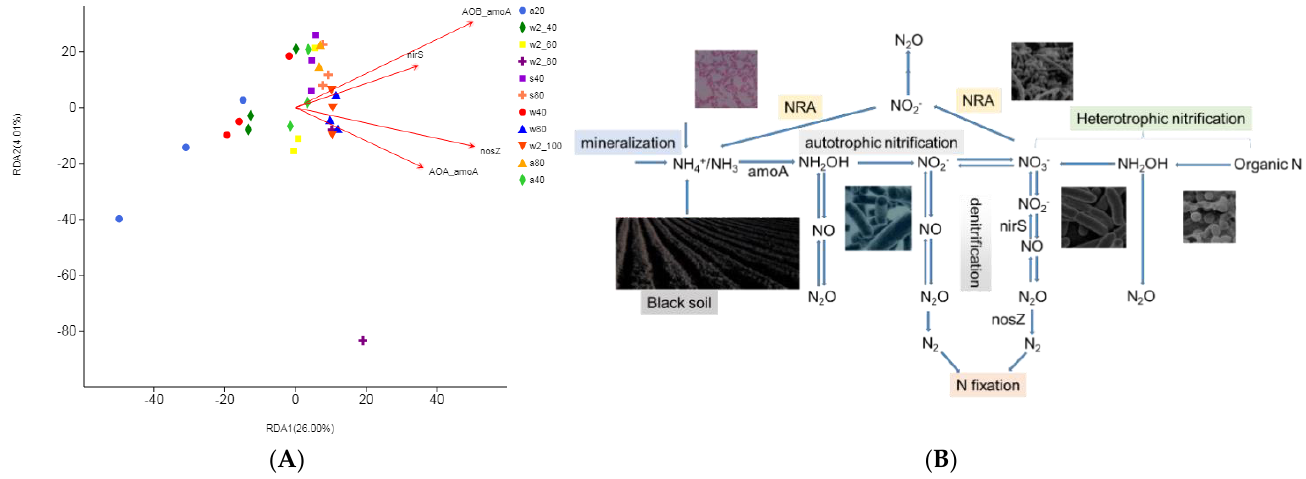
Figure 9. ( A ) OTU level RDA of gene abundance. The abundance of four genes, as four factors, were screened using VIF method. The VIF values of four genes are well below 10 (1.39 – 4.26). a20, 20% WHC for one week; a80, 80% WHC for two weeks; a40, 40% WHC for two weeks; w40, 40% WHC for two weeks; w80, 80% WHC for two weeks; s40, 40% WHC for four weeks; s80, 80% WHC for four weeks; w2_40, 40% WHC for one week; w2_60, 60% WHC for one week; w2_80, 80% WHC for one week; w2_100, 100% WHC for one week. ( B ) Microbial nitrification/denitrification and related nitrogen transformation pathways in black soil.